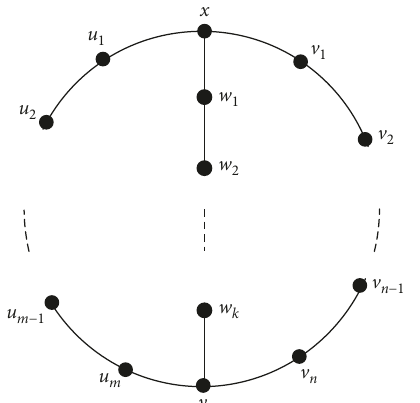
Figure 4: Bicyclic graph for the proof of Proposition 3.